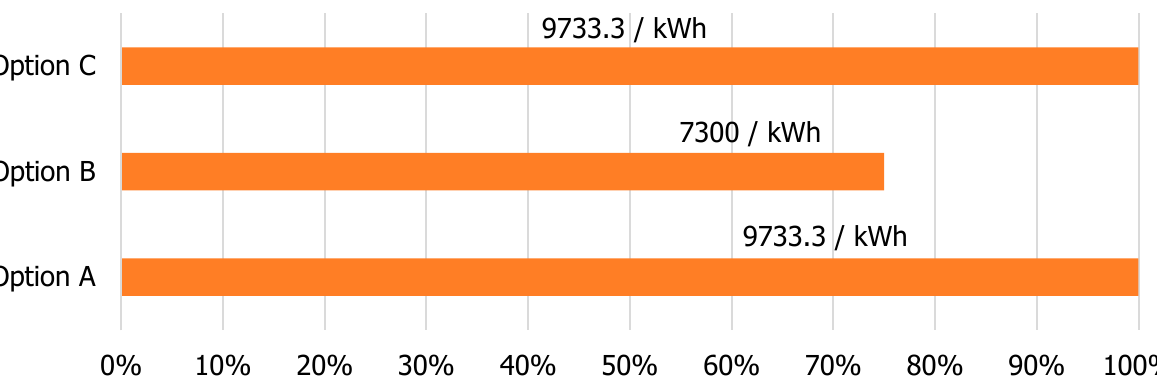
Figure 32. Comparison of energy consumption.